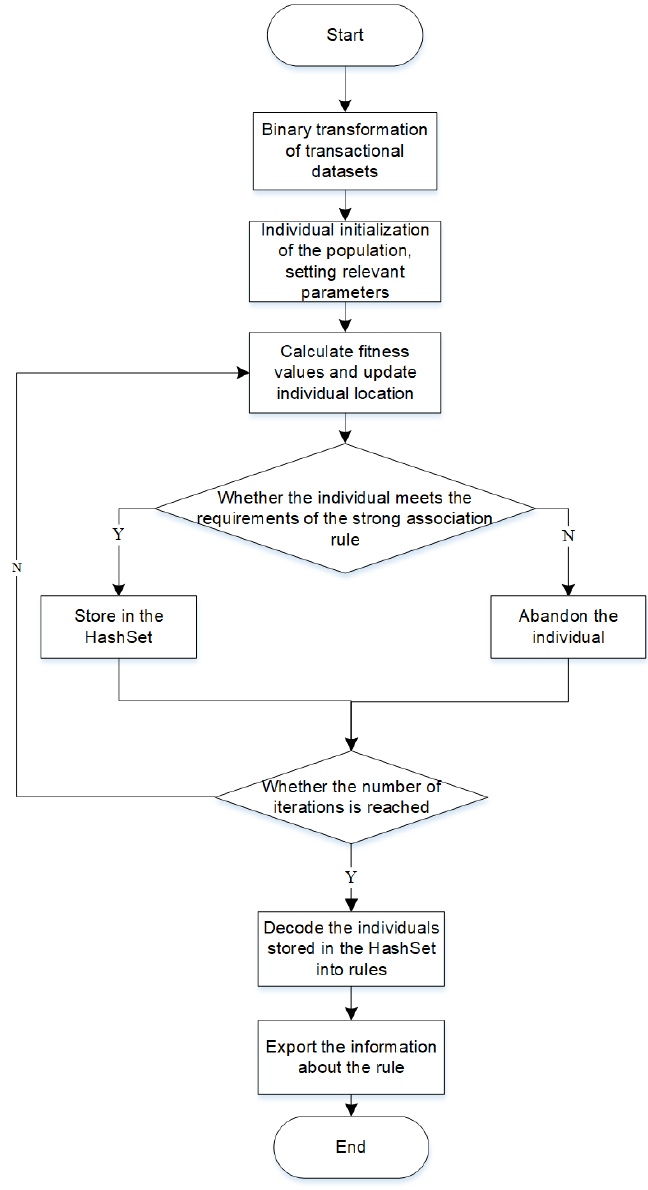
Figure 2. Flowchart of the proposed hybrid algorithms for ARM.